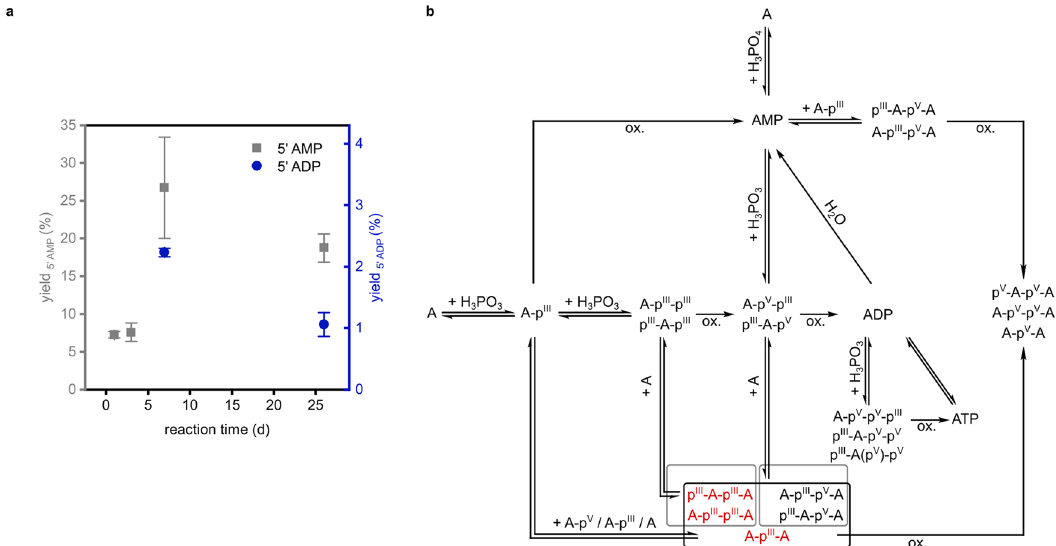
Fig. 3 Reaction time dependence and reaction pathways of the phosphorylation. a Yields depending on the reaction time starting from A (100 mM), H 3 PO 3 (3.0 eq.) and urea (1.0 eq.). Depicted are mean values, error bars refer to ± s.d and were obtained by double determination via CE (for